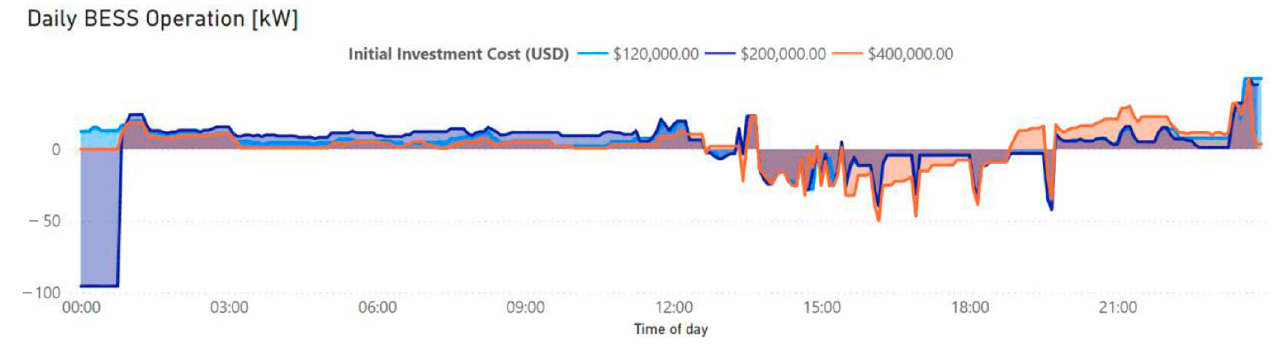
Figure 13. BESS charge and discharge for each initial investment cost.